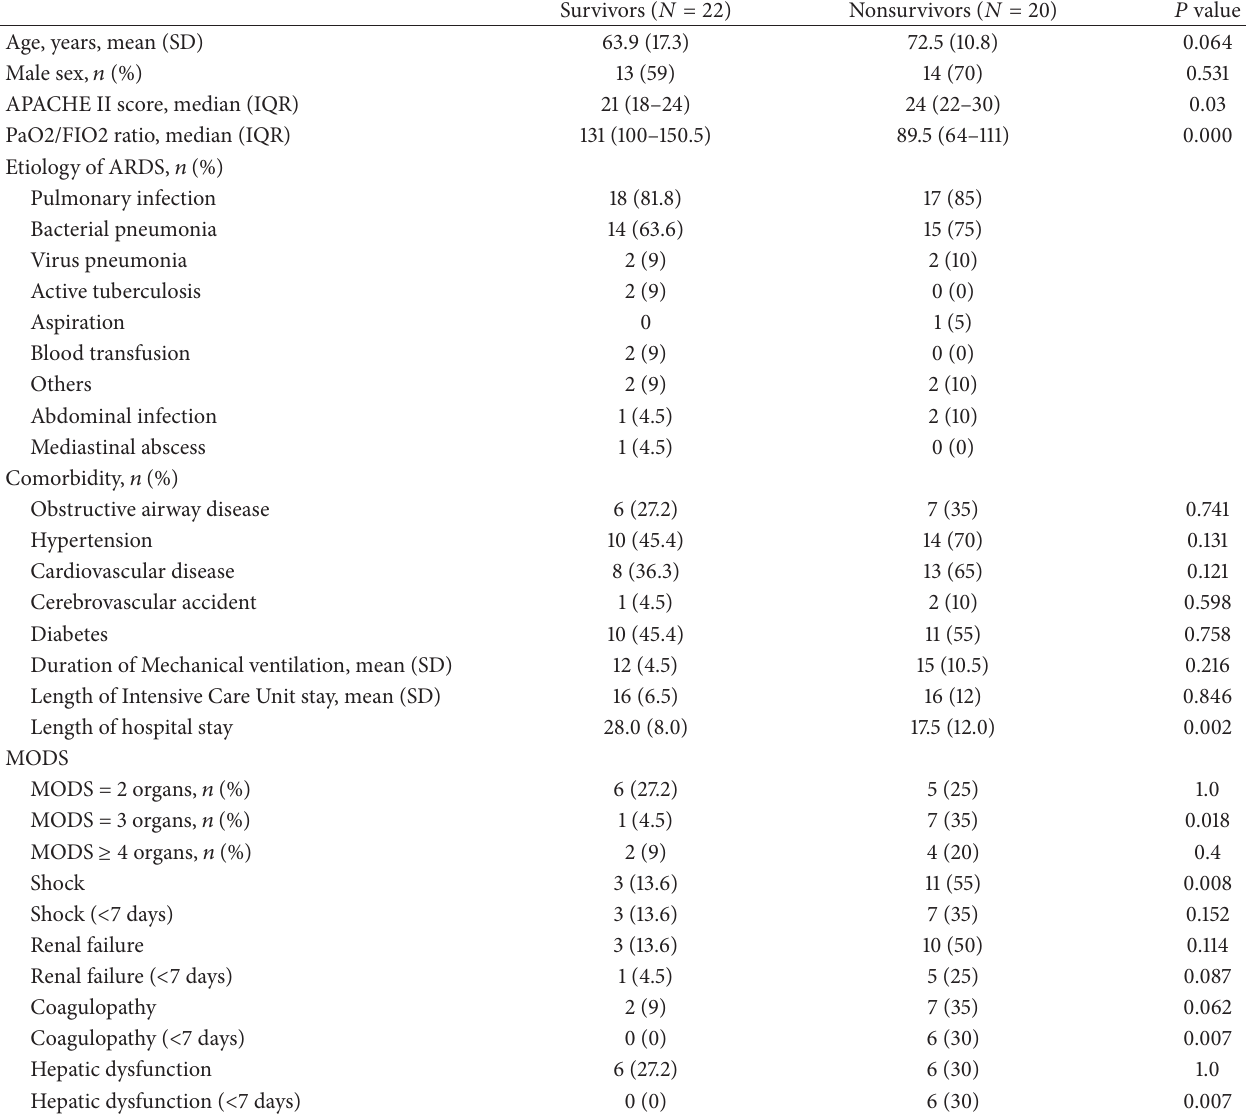
Table 1: Baseline demographics, clinical characteristics, and comorbidity of 42 patients with acute respiratory distress